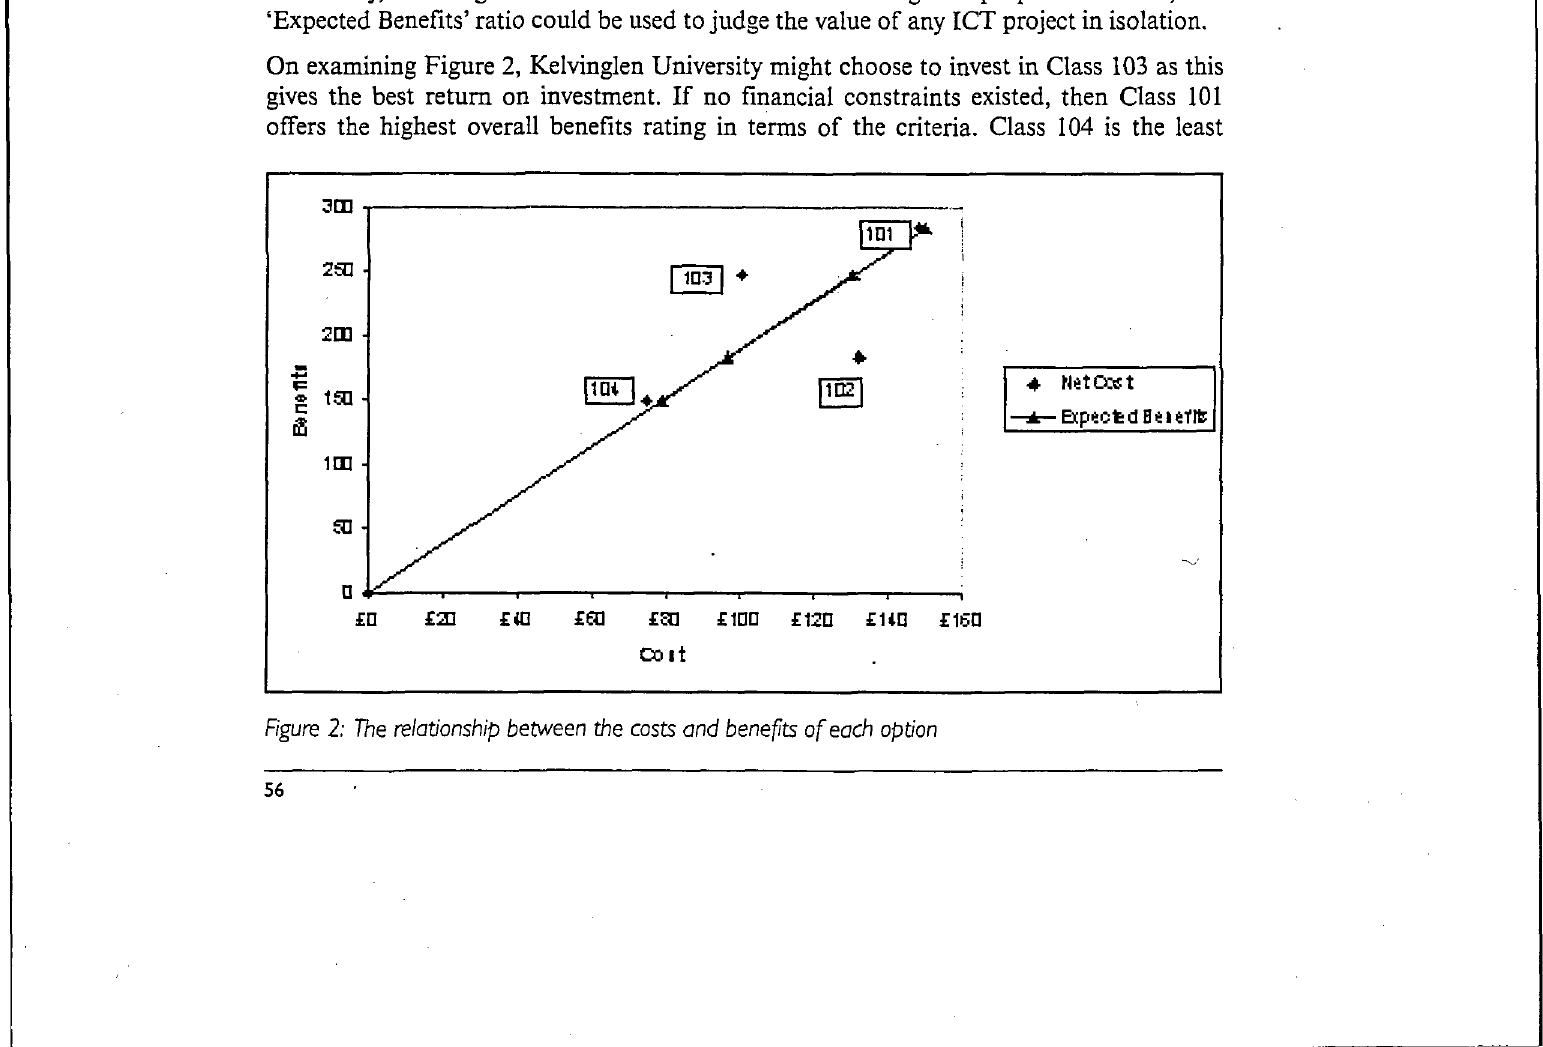
Table 7: The cost-benefit ratio for each option (benefits divided by annual costs)